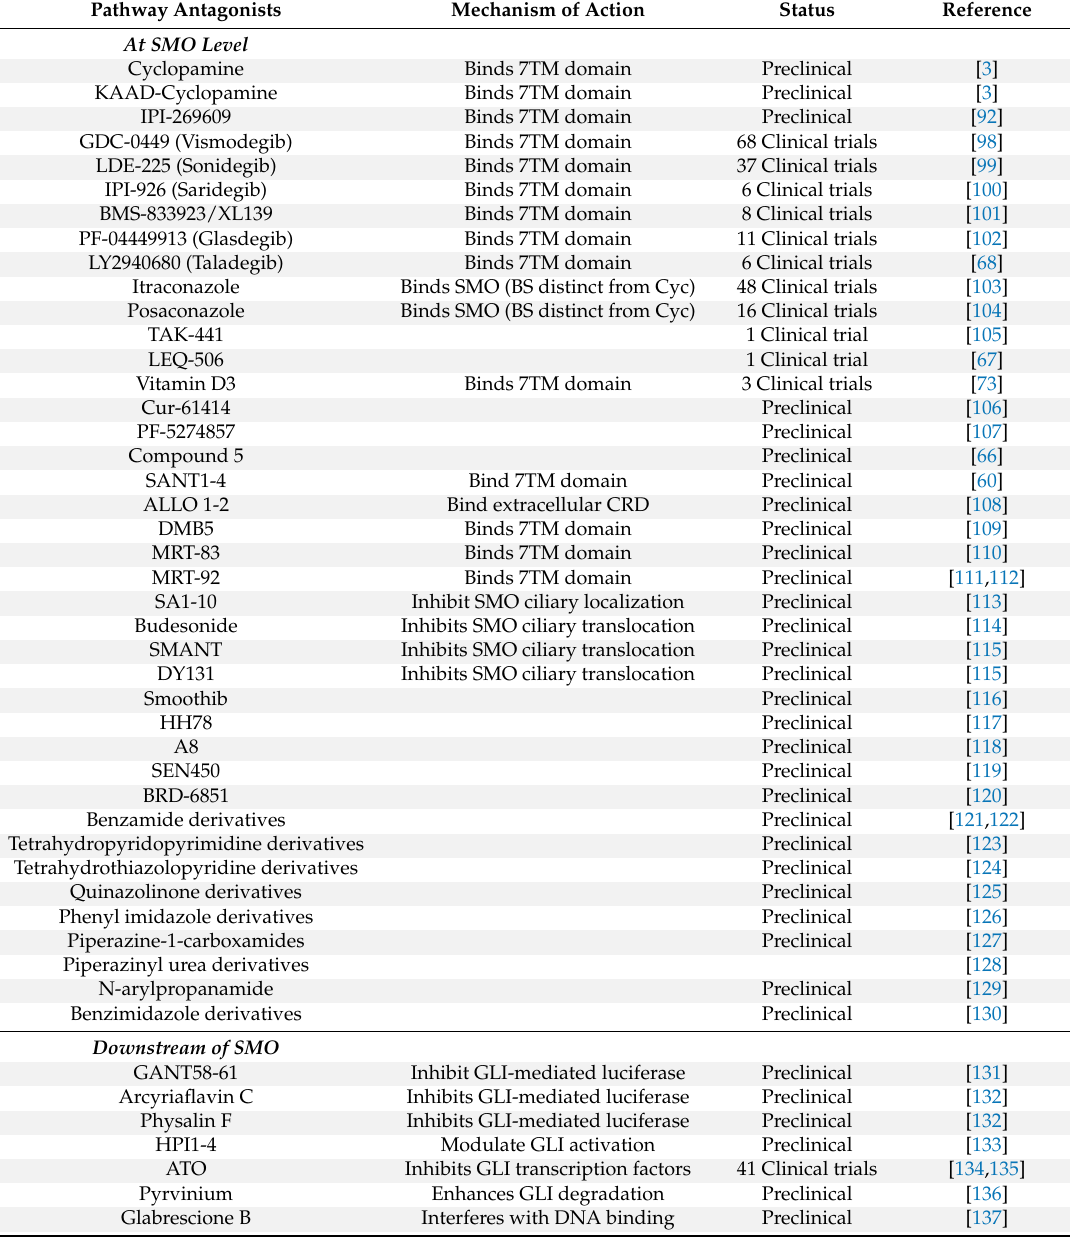
Table 2. Inhibitors of the HH